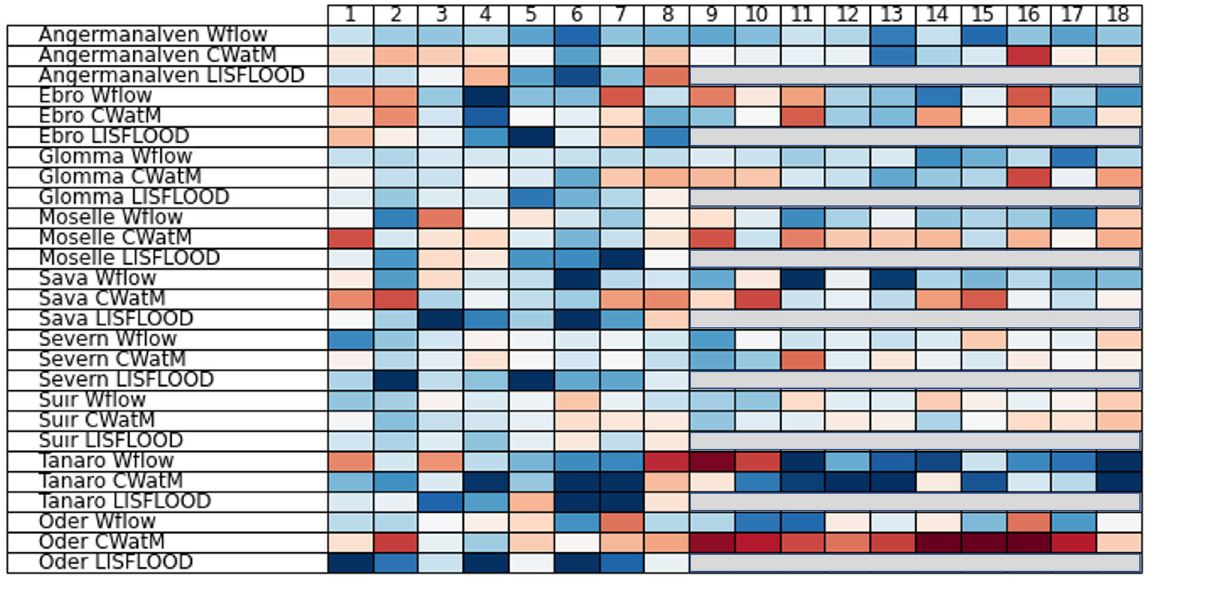
different CORDEX GCM-RCM combinations listed in Table 2